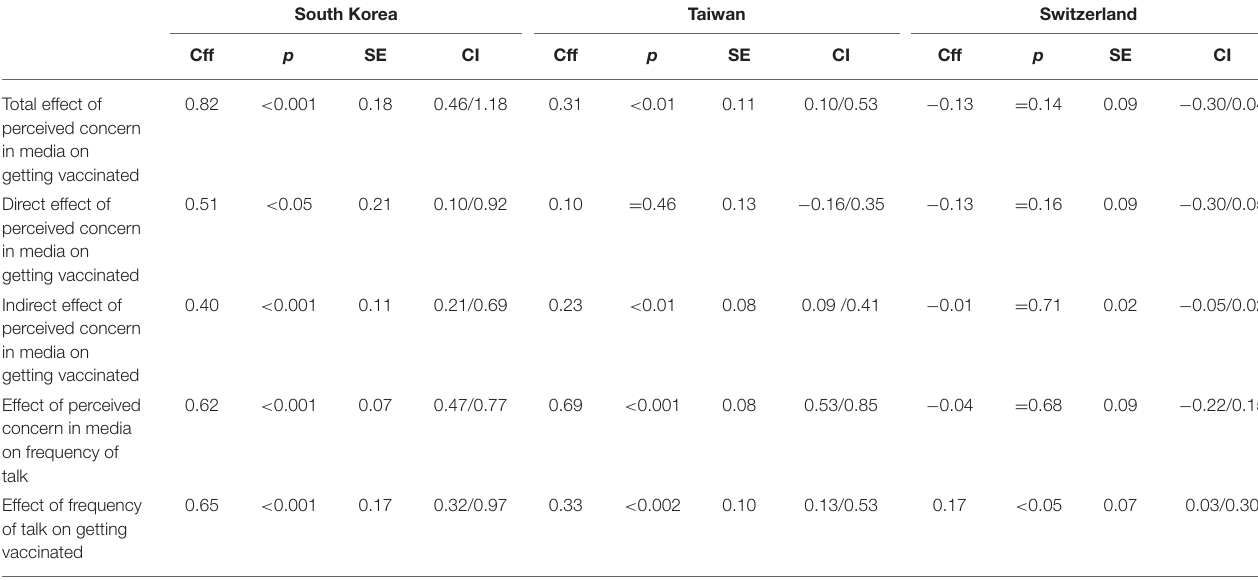
TABLE 4 | Mediation analysis: Path coefficients.